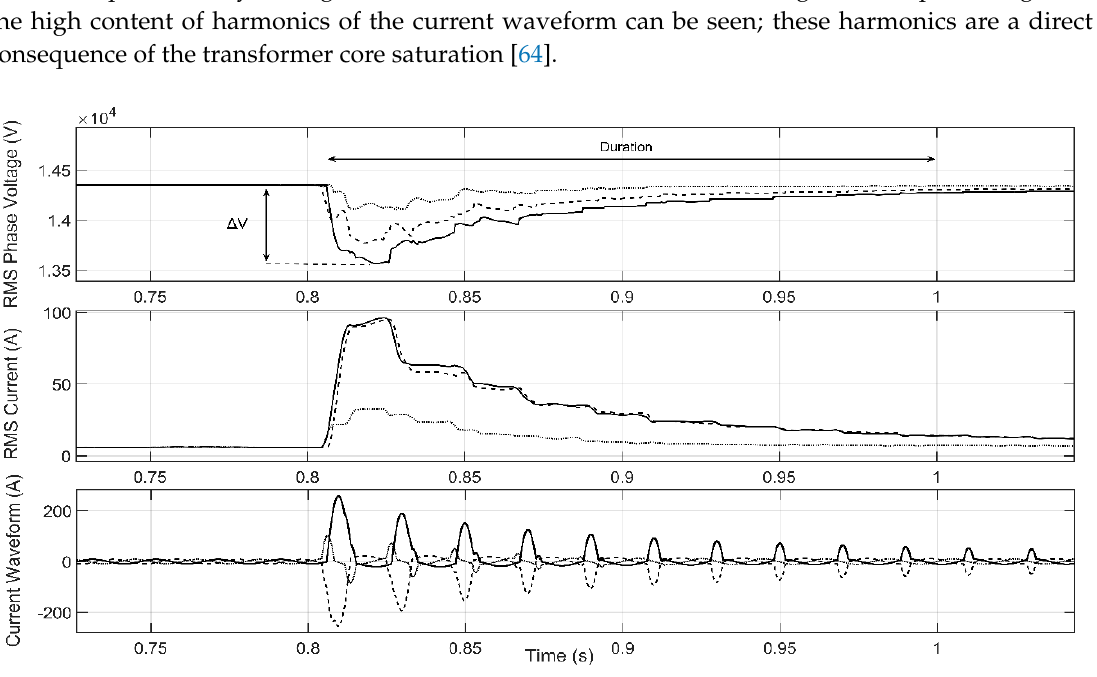
Figure 4. Example of a non-constant voltage sag produced by transformer energization.